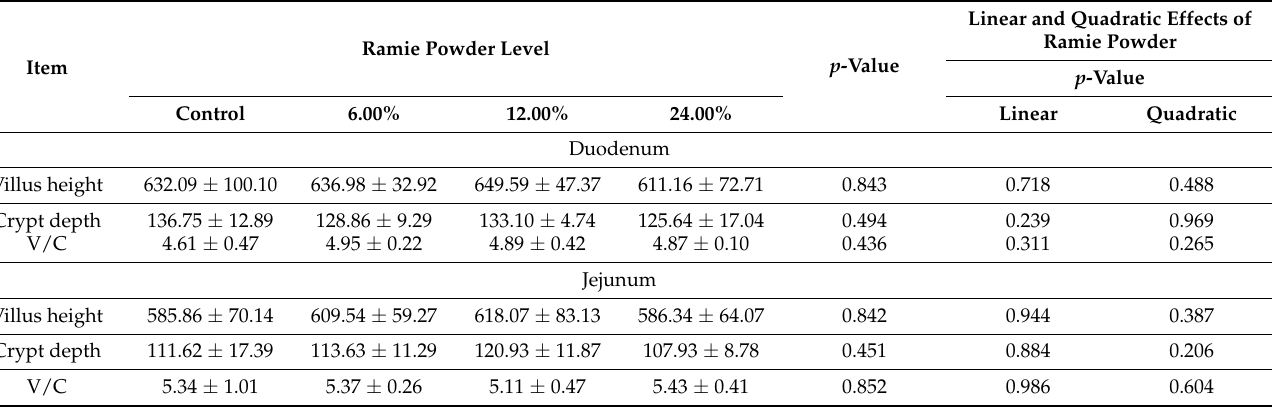
Table 5. Effect of the different ramie powder levels in the diets on the intestinal mucosal morphology of 98 day old Yanling white geese ( µ